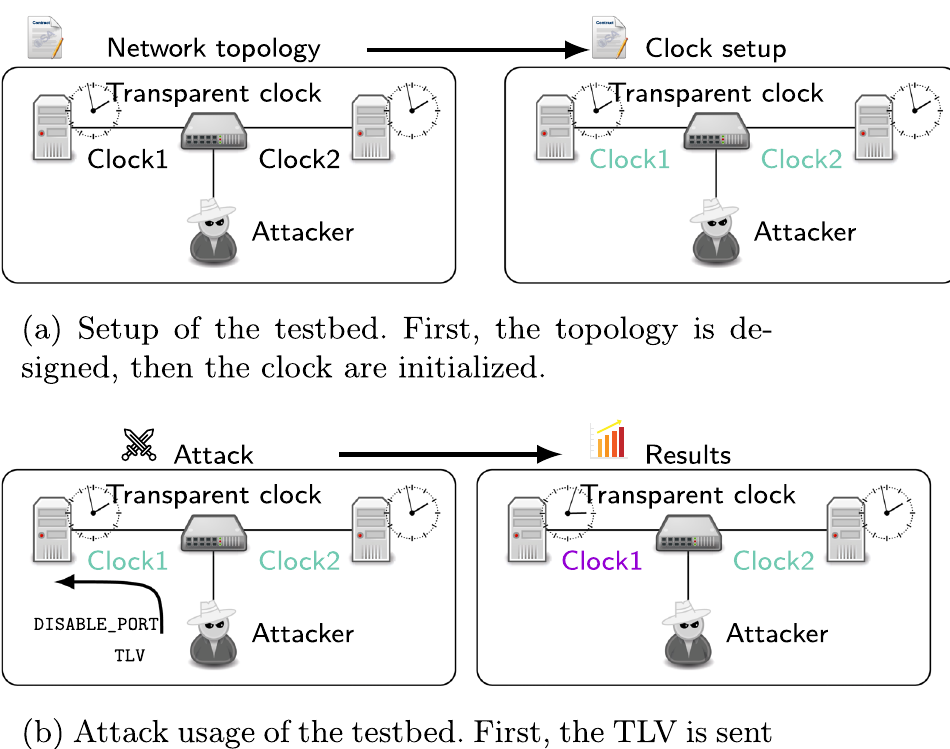
Fig. 5 Testbed design and usage for the Clock Disable Port Attack. Our modular framework allows to build a system with IaC technologies, which can be configured to include an arbitrary number of entities such as clocks, attackers, etc. connected according to different topologies. In black, entities that are not part of the time synchronization platform; in green, entities that are correctly and mutually synchronized; in